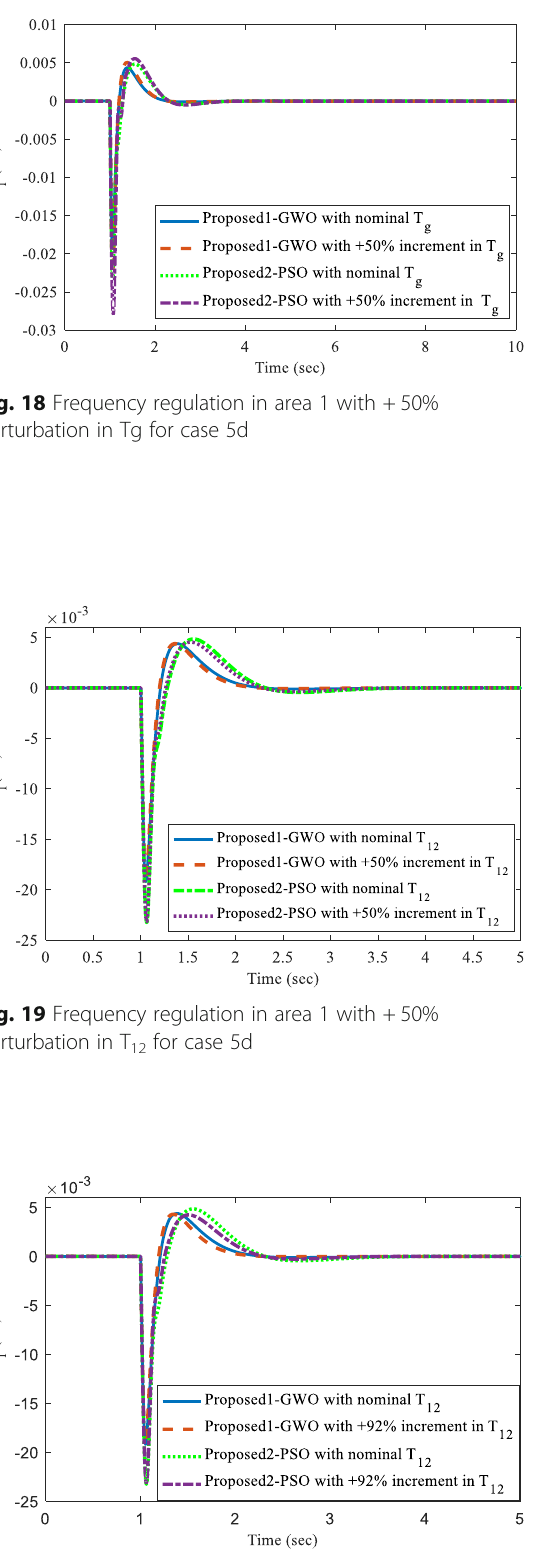
Fig. 20 Frequency regulation in area 1 with + 92% perturbation in T 12 for case 5d